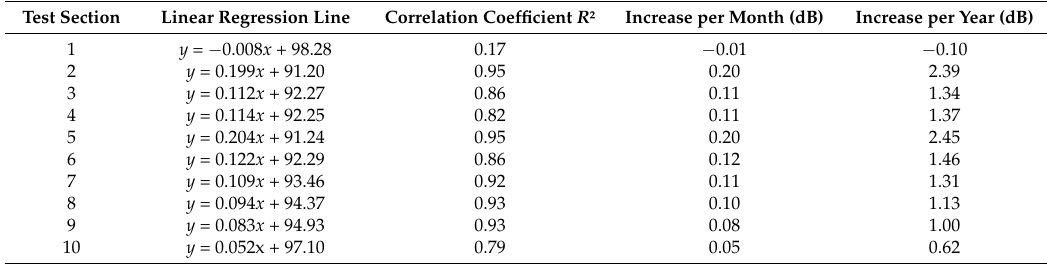
Table 4. Average noise increase per month and per year calculated from the CPX results (P1